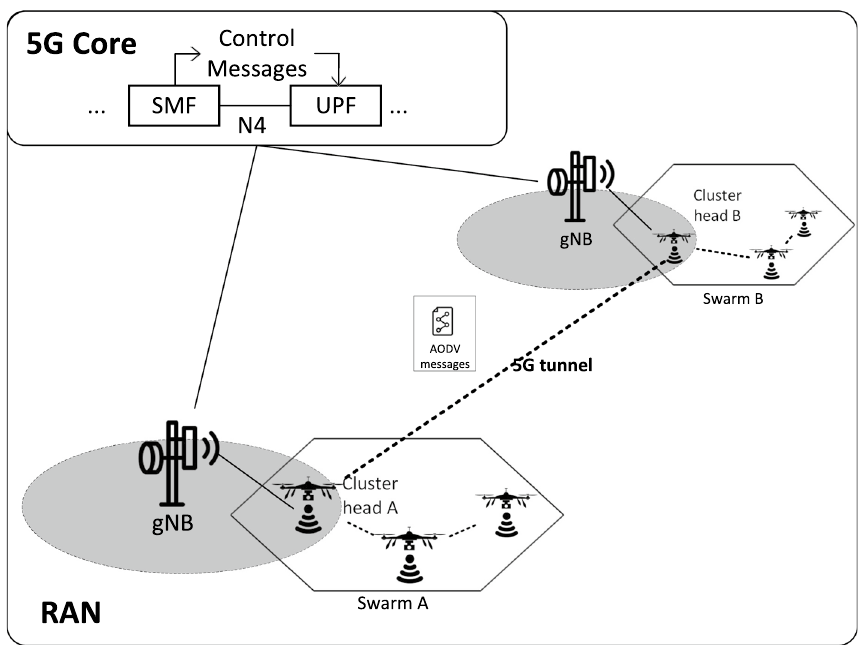
Fig. 6 Drone Swarm Attack Scenario: Base scenario for the implementation of a 5G tunnel‑targeting attack on two communicating drone